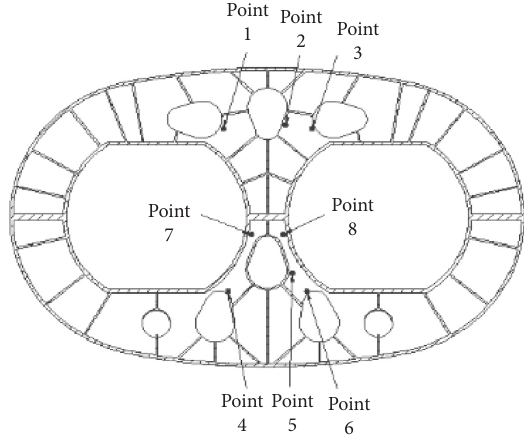
Figure 15: Distribution of measuring points.